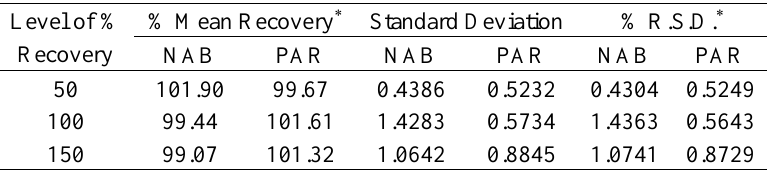
Table 2. Recovery studies of NAB and